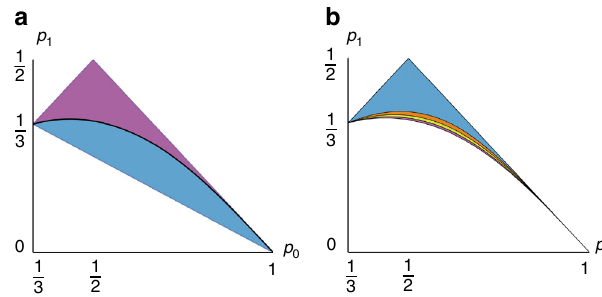
Fig. 4 The region of qutrit passive states and the activable set. Consider a P 2 E i i j i i h j qutrit system with Hamiltonian H P ¼ , whose state ρ P ¼ P i ¼ 0 P 2 p i i j i i h j is passive. The Hamiltonian is fi xed by choosing two N ; M 2 N i ¼ 0 P such that M Δ E 10 − N Δ E 21 = 0, where Δ E 10 = E 1 − E 0 and Δ E 21 = E 2 − E 1 . In both panels we set M = 2 and N = 1. a The space of passive states can be represented in a two-dimensional plot, whose axes represent the probability of occupation of the ground state p 0 , and fi rst excited state p 1 . The purple region represents the subset R 1 , de fi ned in Eq. (23), while the light blue region represents the subset R 2 , de fi ned in Eq. (24). The black line is R 3 , that is, the set of completely passive states, see Eq. (25). b For a given cycle S m , n we can draw the set of passive states from which energy can be extracted, R þ m ; n . In this plot, we show the regions R þ (light 3 ; 1 blue), R þ (orange) and R þ (yellow), which cover the region R 1 (purple) 11 ; 5 5 ; 2 better and better as m and n (the number of hot and cold swaps, respectively)